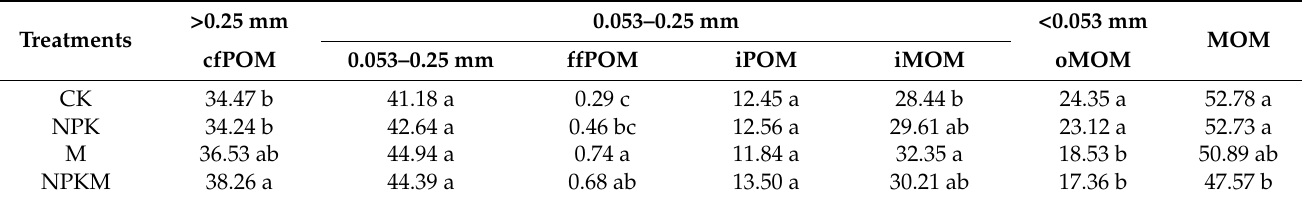
Table 2. Soil aggregate distribution (%) under different fertilization